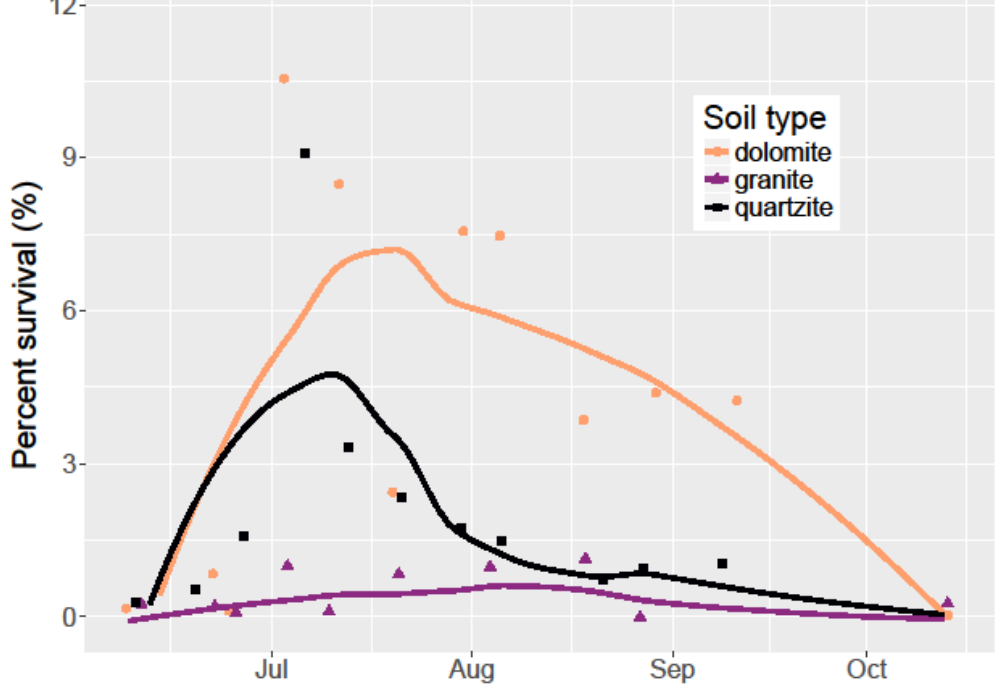
Figure 5. Seedling germination and survival over the course of the 2015 growing season. Each point is the percent of living seedlings per seeds sown, including all 12 containers totaled for each soil type. Lines were drawn using local regression (LOESS) smoothing with a span of 0.75.